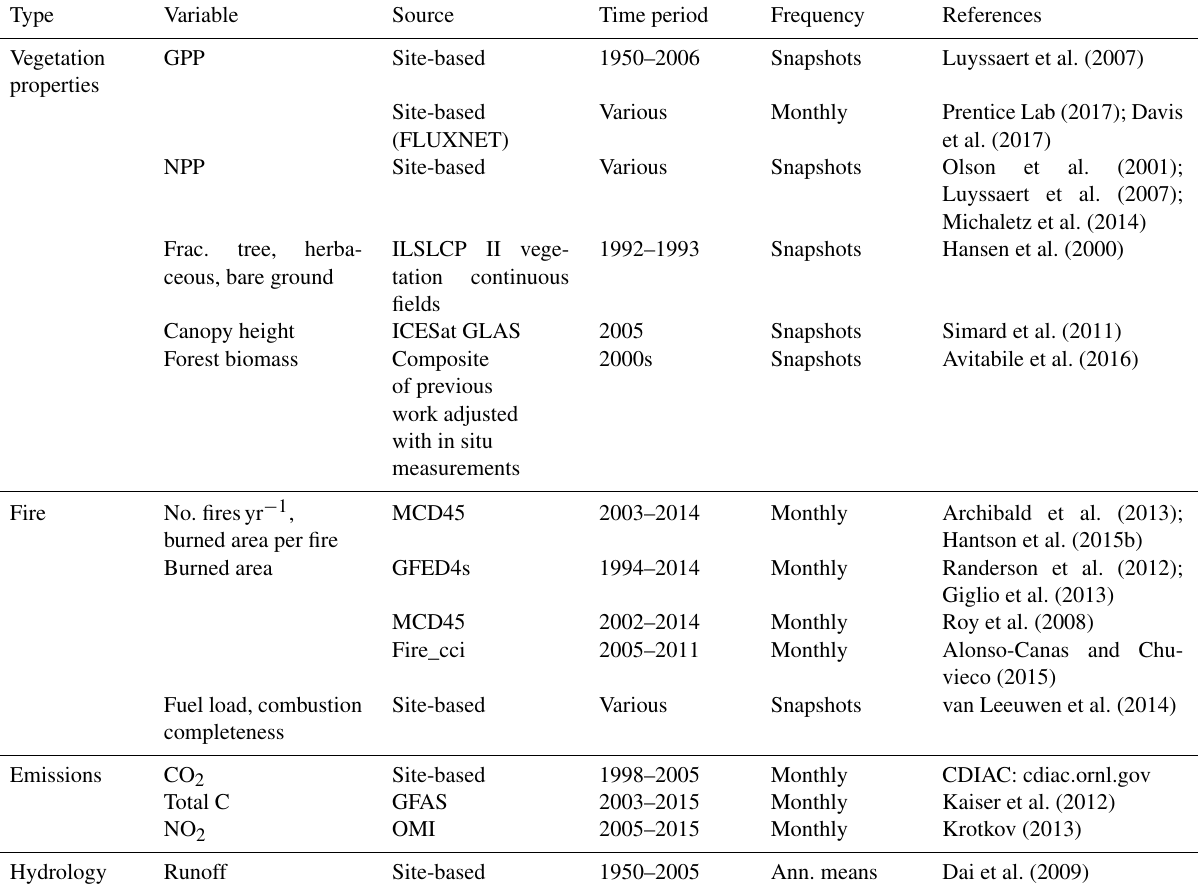
Table 4. Summary description of the observational datasets to be used for model evaluation. “Frequency” refers to the temporal resolution at which the analyses will be performed, which may be coarser than the native resolution of the